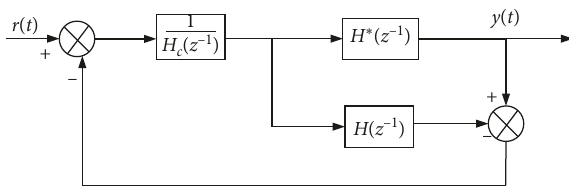
Figure 3: The internal model control structure of SDMC.